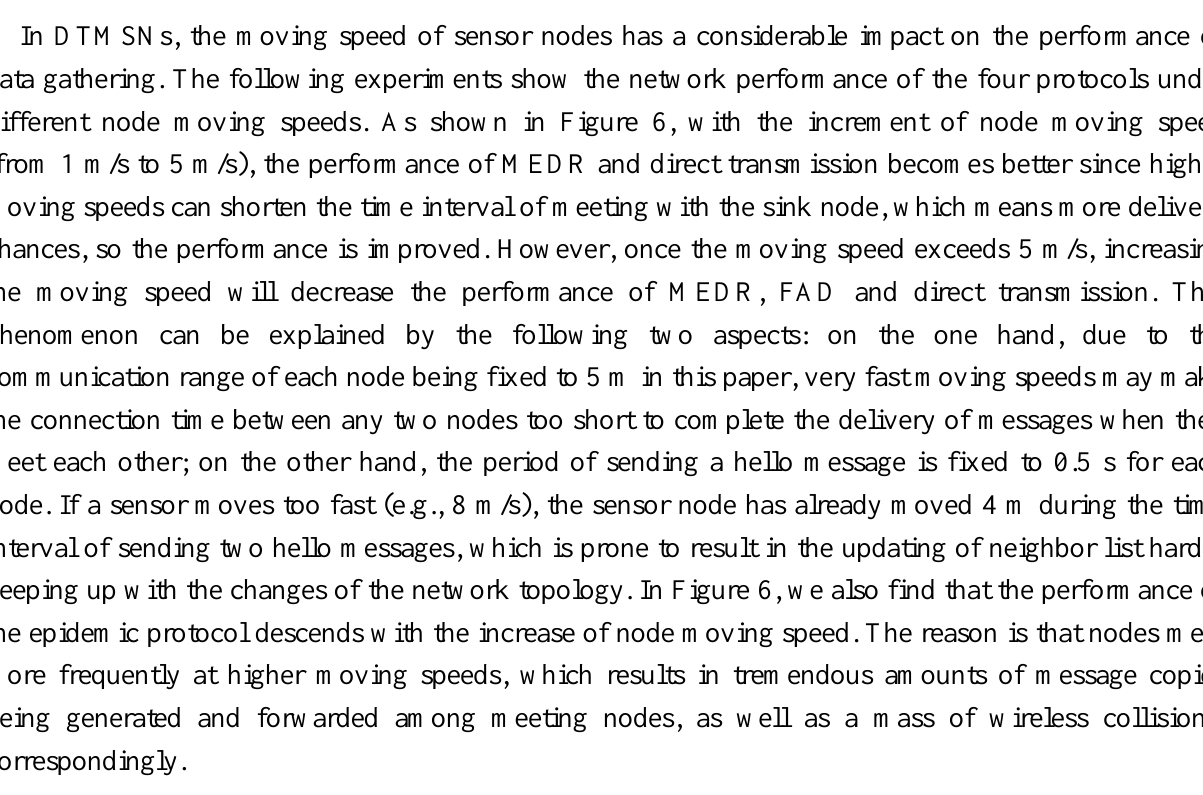
Figure 6. Impact of node move speed. (a) Average delivery ratio; (b) Average